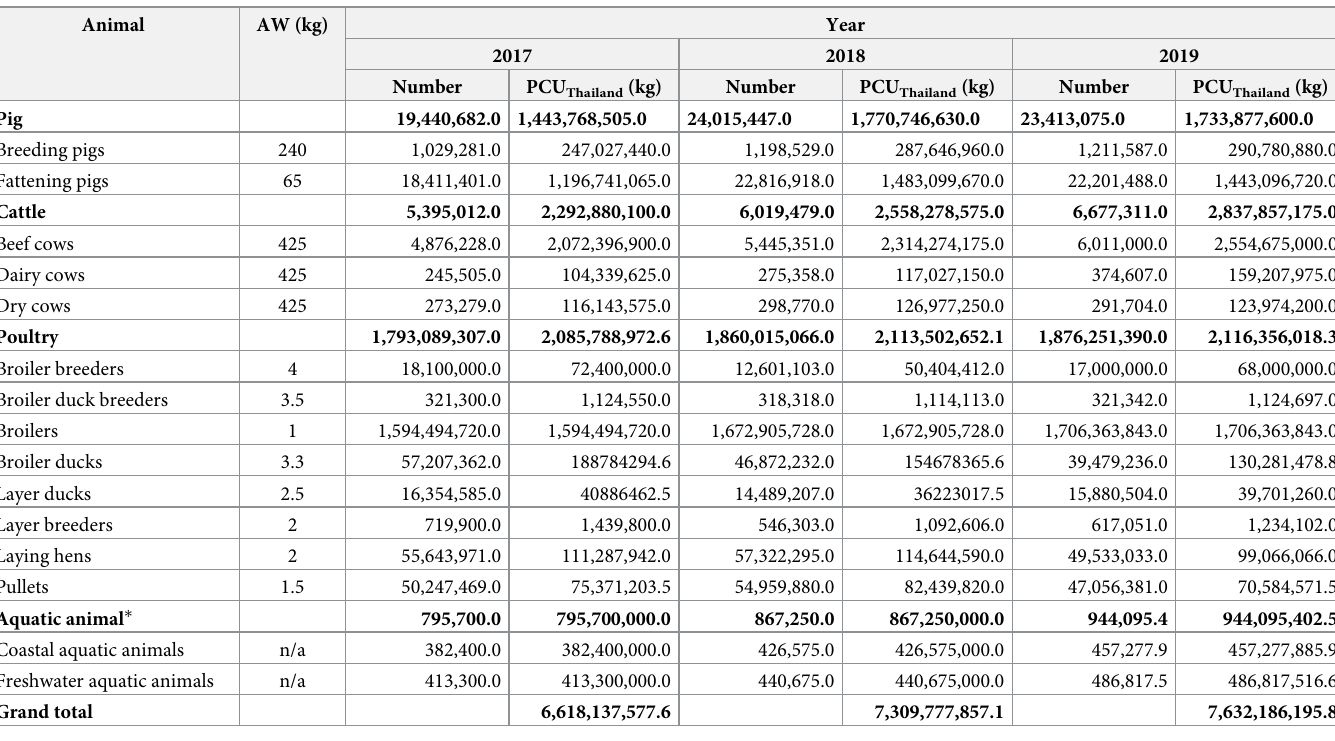
Table 2. Food producing animals in the Population Correction Unit (PCU)